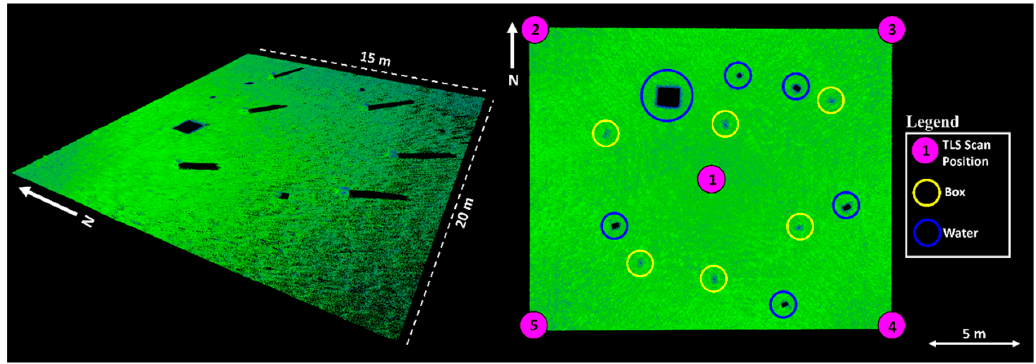
Figure 7. Photograph of the test site with the Riegl VZ-400 TLS, cardboard boxes, and water receptacles.